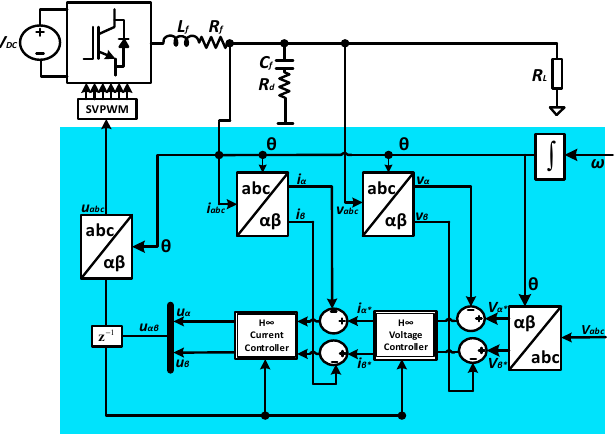
∞ robust controller.